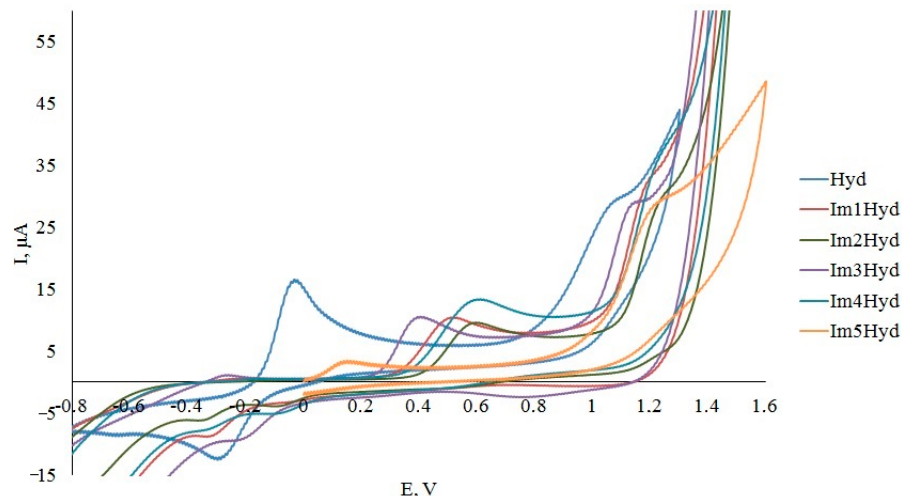
Figure 5. Cyclic voltammograms of pyrogallol and imidazolylpyrogallols recorded on the glassy